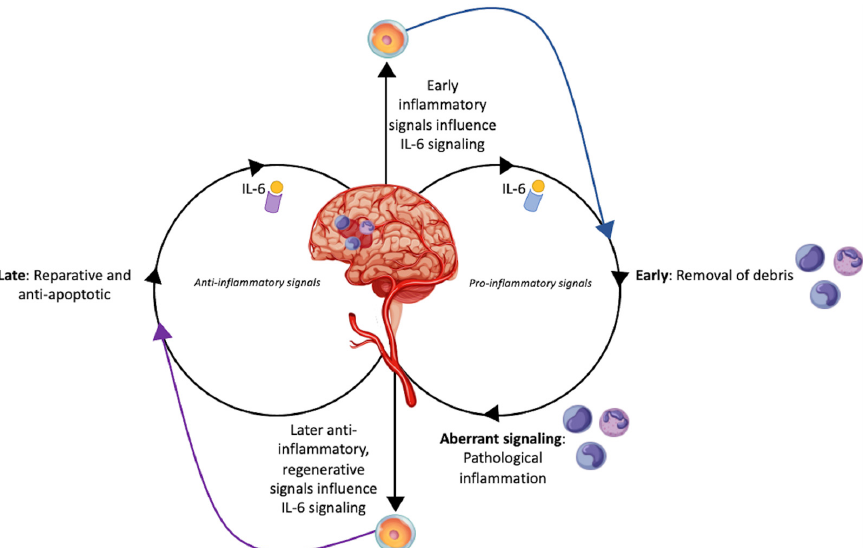
Figure 1. Interleukin-6 modulation by stem cells in stroke. This figure illustrates the dual role of interleukin-6 signaling in stroke pathophysiology. Early signaling of IL-6 can be beneficial in instigating debris clean up after stroke, but prolonged pro-inflammatory IL-6 signaling can be detrimental. Contrarily, late, reparative IL-6 signaling can aid in restoring neurological function.